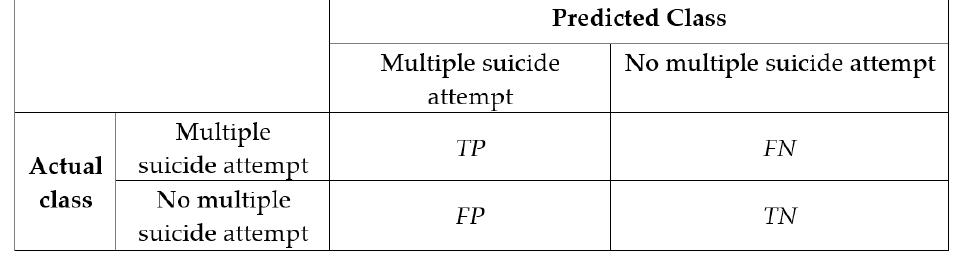
Figure 1. Confusion matrix.